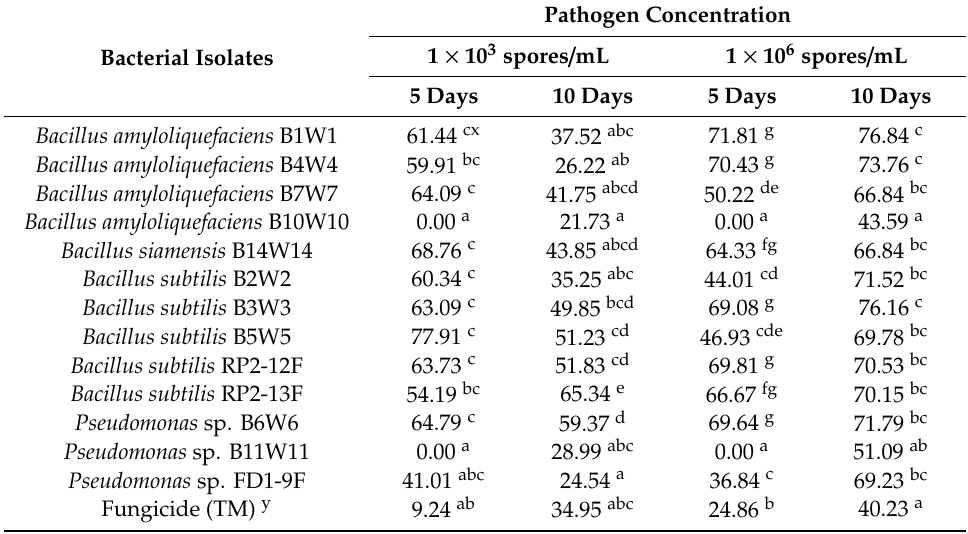
Table 5. Disease severity (%) of brown rot disease ( Monilinia fructigena ) as a ff ected by bacterial isolates and pathogen pressure 5 and 10 days post-incubation periods at 24 ◦